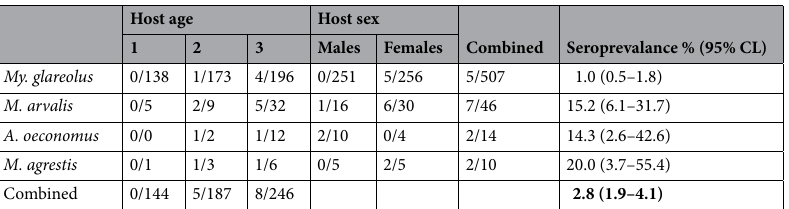
Table 1. Seroprevalence of Toxocara spp. in voles from NE Poland. The table shows the number of positive animals by sample size in the three age classes, in the sexes and combined, as well as the overall